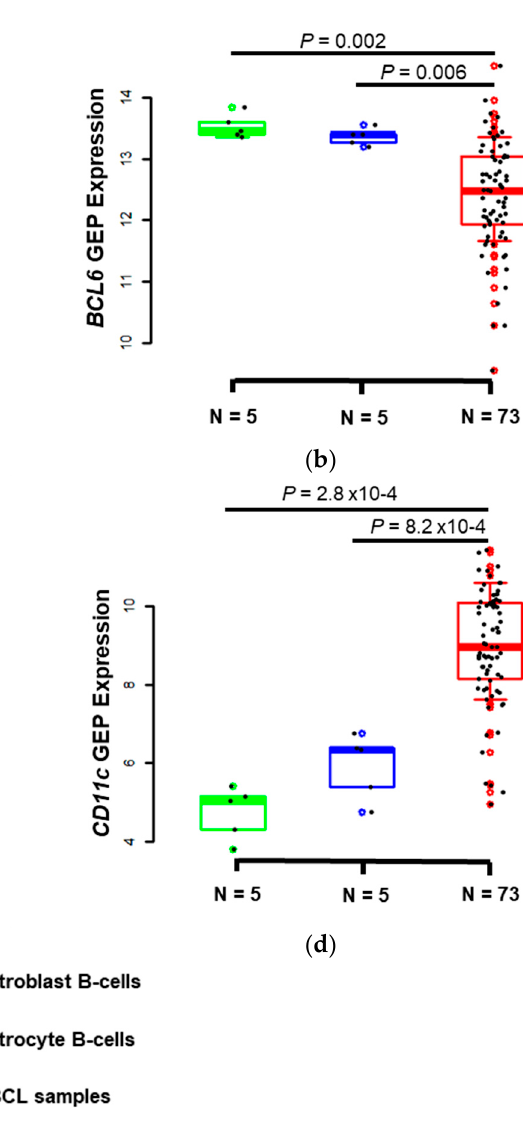
Figure 5. Comparison of BCL2 ( a ), BCL6 ( b ), LAIR1 ( c ), and CD11c ( d ) gene expression in DLBCL samples and in normal centrocytes and centro-blasts (GSE12195 dataset). The box-plot diagrams include the median value and the interquartile rage (IQR). The error bars represent the minimum values under the median and the outliers are identified as the third quartile plus 1.5 IQR (R I386 3.4.0 software, R Foundation). Results were compared using the Mann-Whitney U-test.